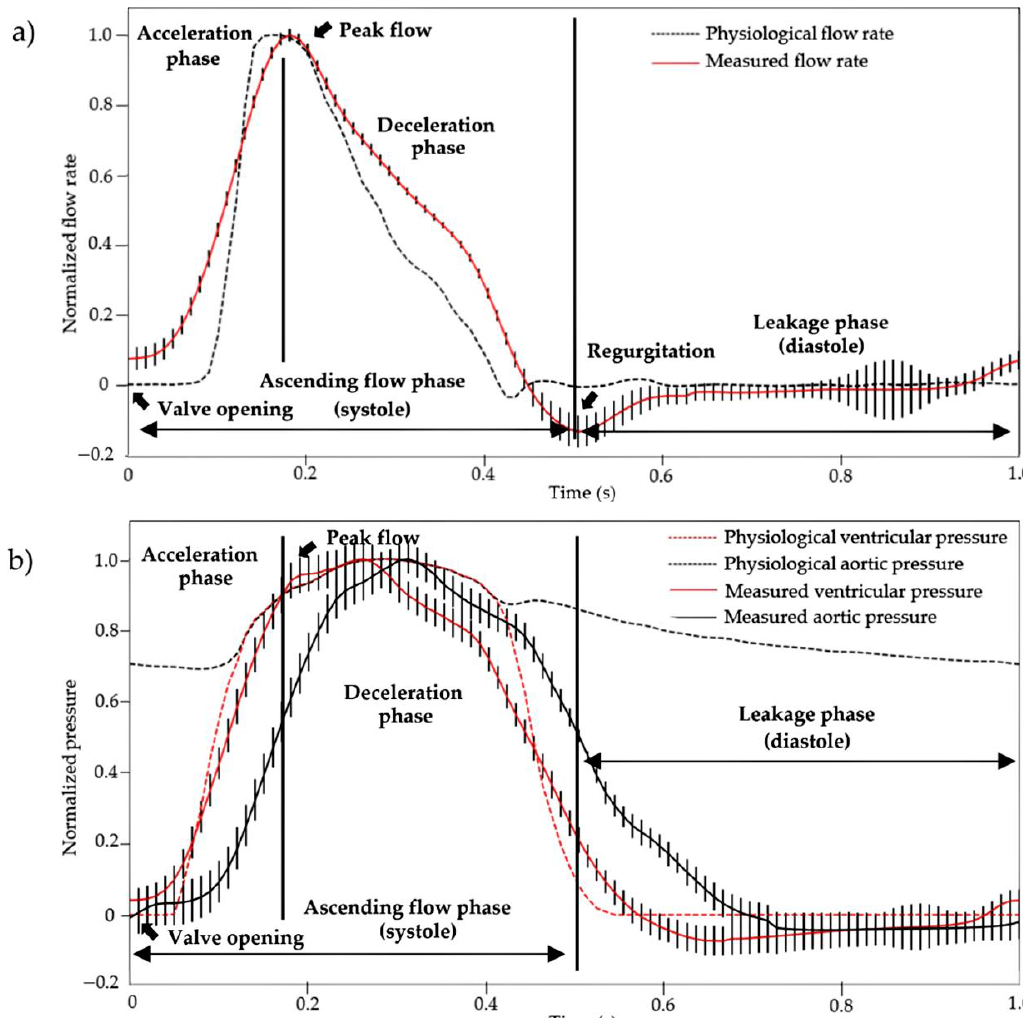
Figure 7. ( a ) Average measured flow rate and ( b ) pressures (aortic and ventricular) normalized profiles ( n = 12 cardiac cycles) at 60 BPM. These were obtained using a custom-made cardiac bioreactor on three aortic valves scaffolds (measured data curves) and compared to the physiological profiles (physiological value curves) [53]. The vertical bars represent the standard deviation at each acquisition time (100 Hz) of the average profiles of the three aortic valve scaffolds.